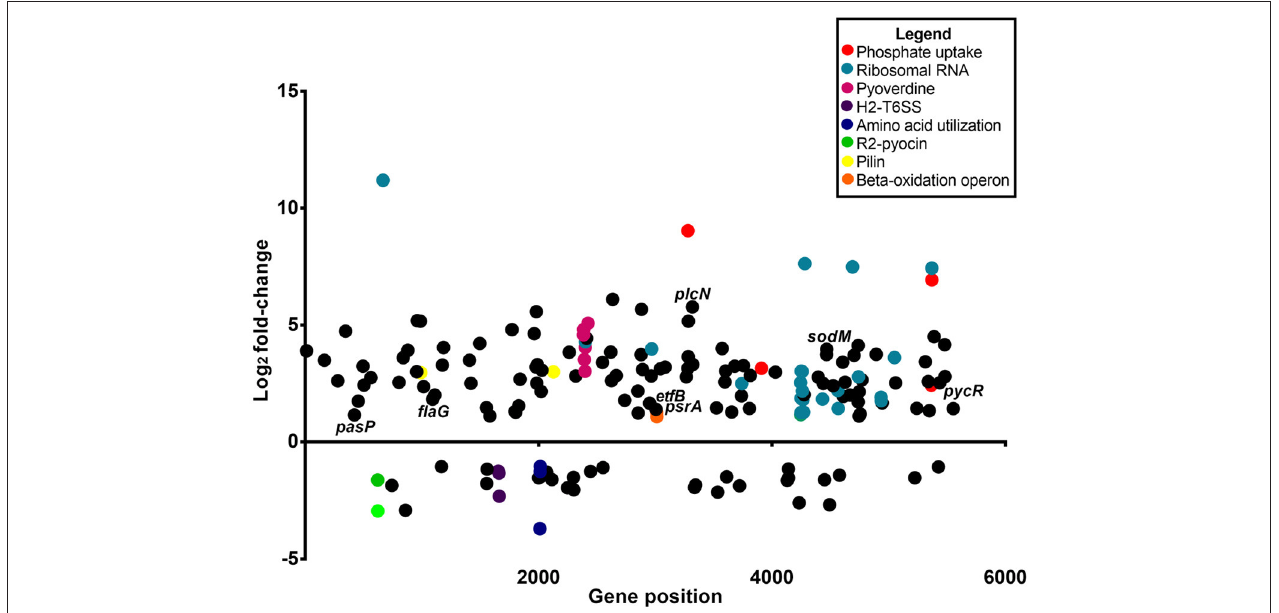
FIGURE 3 | Differential gene expression of P. aeruginosa PASS1 in zebrafish compared to PASS1 cells grown in Luria-Bertani medium. Each dot represents a gene within the P. aeruginosa PASS1 genome (x-axis) and its fold-change (log 2 ) expression in vivo , 3 dpi. Only significantly differentially expressed genes are shown ( p ≤ 0.01 and log 2 fold-change cut-off − 1 ≥ to ≤ 1).